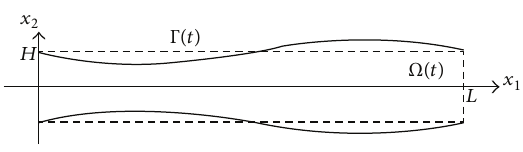
Figure 1: Sketch of flow region [9,